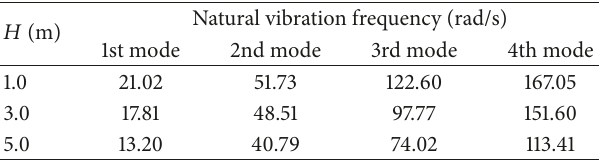
continuation techniques. The solutions between the two limit points are unstable.